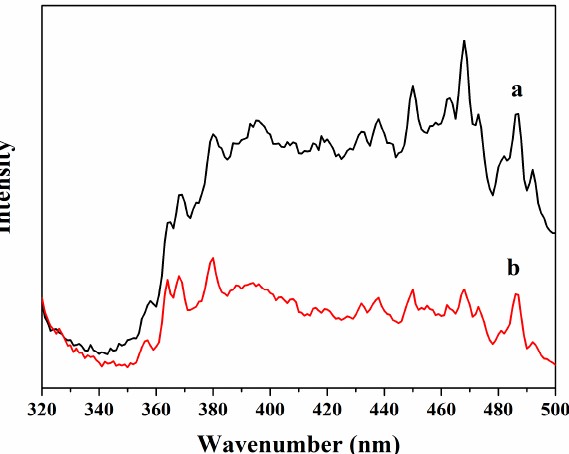
Figure 4. ( a ) UV–Vis DRS, and ( b ) bandgap energies of TiO 2 NTs and 0.5 wt.% Au/TiO 2 NTs.